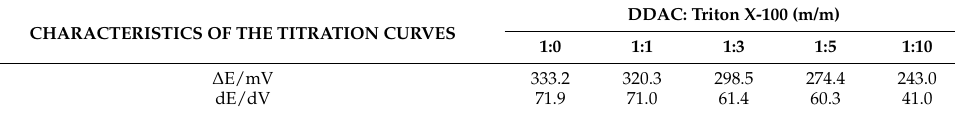
Table 7. Characteristics of the titration curves of the model mixtures of DDAC and nonionic surfactant Triton X-100 in different proportions ( w / w ), using NaDDS as titrant ( c = 4 × 10 − 3 M) and DODI-TPB as a potentiometric